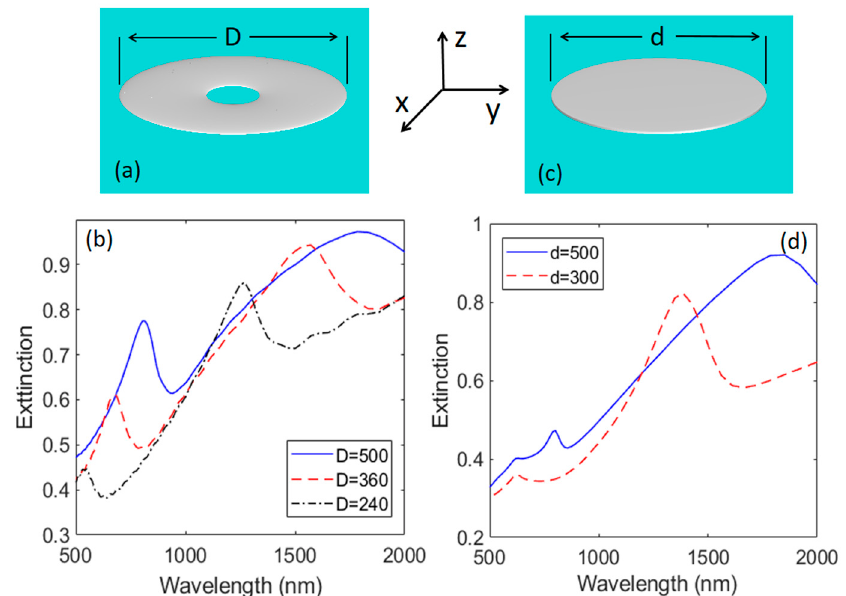
Figure 7. ( a ) Simulation structural model of an Ag N-donut with an external diameter of D. ( b ) Extinction of Ag N-donuts with D = 500 (solid line), 360 (dashed line), and 240 nm (dashed-dotted line). ( c ) Simulation structural model of an Ag N-discs with diameter d. ( d ) Extinction spectra of the Ag N-discs with d = 500 (solid line) and 300 nm (dashed line). The thicknesses of the N-donuts are considered to be 10 nm and those of N-discs to be 7 nm.